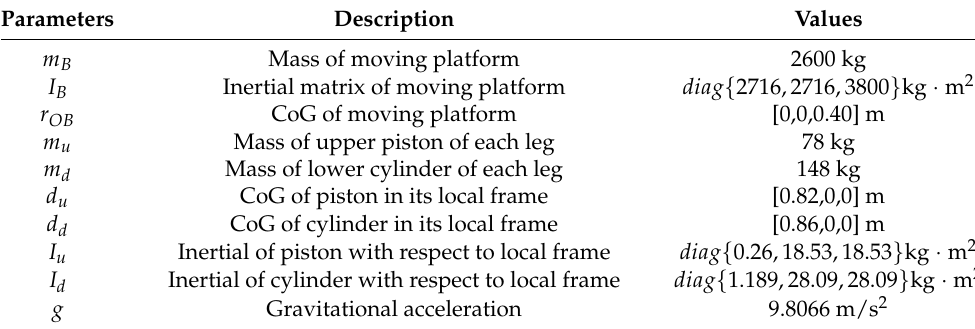
Table 1. Mass and inertial parameters of the G-S platform. Parameters